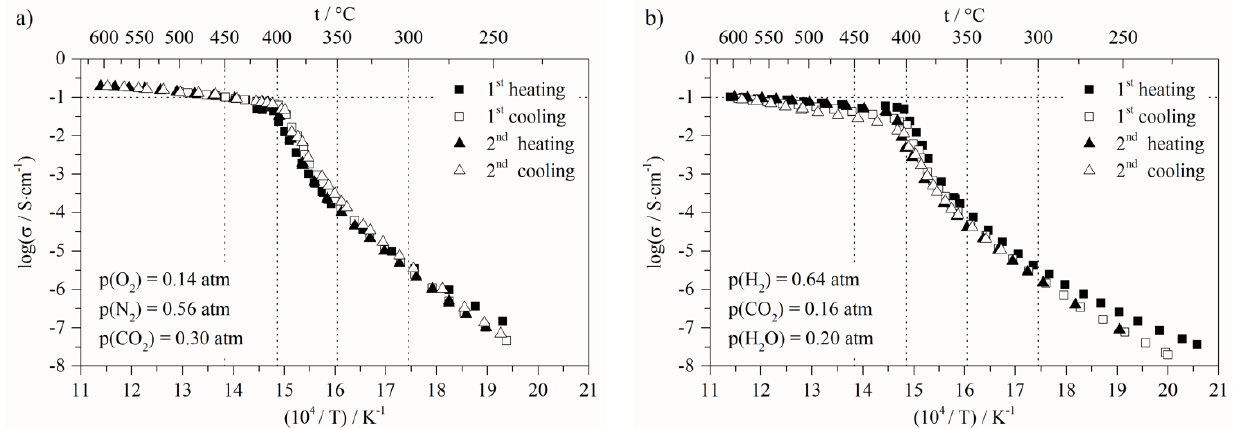
Figure 7. Influence of CO 2 addition on electric behavior and stability of SDC—LiNaK composite electrolyte in: ( a ) oxidant compartment and ( b ) reducing compartment of a Molten Carbonate Fuel Cell (MCFC) operated in standard conditions. Arrhenius diagrams represent two heating/cooling cycles for both MCFC simulated atmospheres.